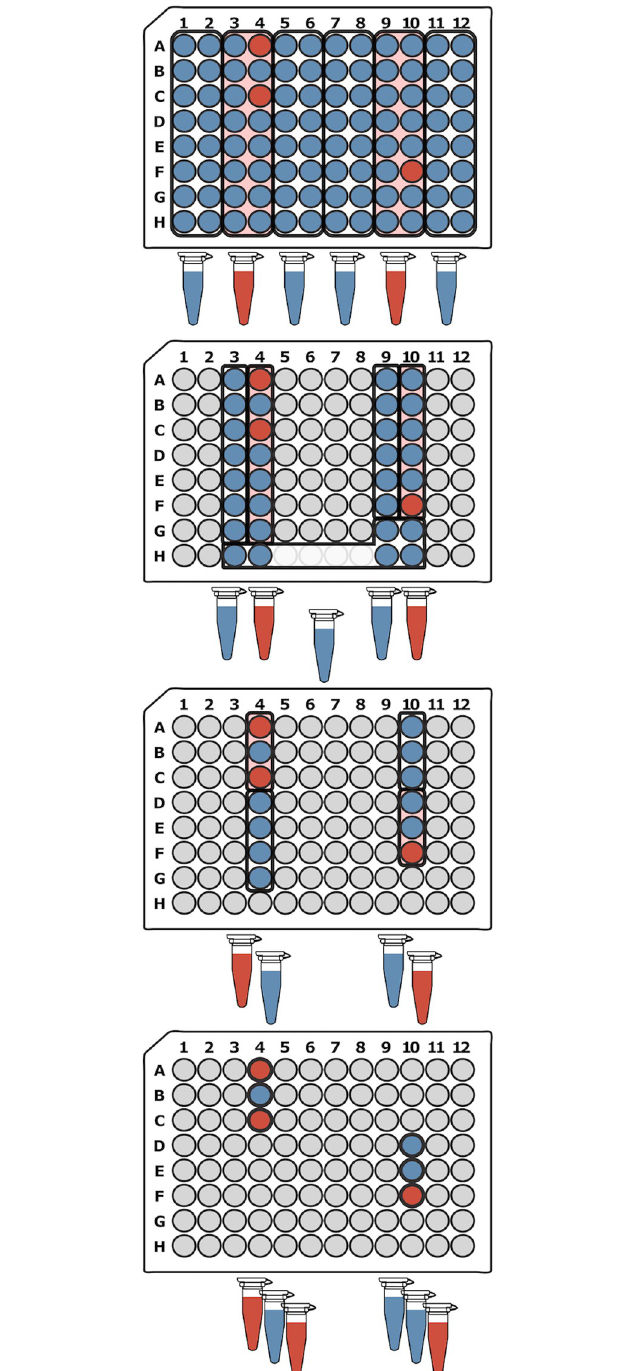
Fig 3. S-Stage pooling example. For 96 samples with an estimate of 3 positive samples, the S-Stage algorithm requires 4 steps. In the first step (top 96 well plate), 96 samples are tested in 6 groups (black outline) of 16. In the next step, the samples in the positive pools from the previous step are arbitrarily redivided into 5 groups of 6 or 7 samples and tested. In the third step, the samples from positive pools from step 2 are redivided into 4 groups of 3 or 4. In the final step, individual testing is performed on samples from the positive pools in step 3. The number of tests required depends on the initial arrangement of positive samples within the pools but in this example 21 tests are required to identify 3 positive samples (red wells). The number of tests is lower than the upper bound in this case due to the fortunate placement of two positive samples in the same pool in steps 1-3.